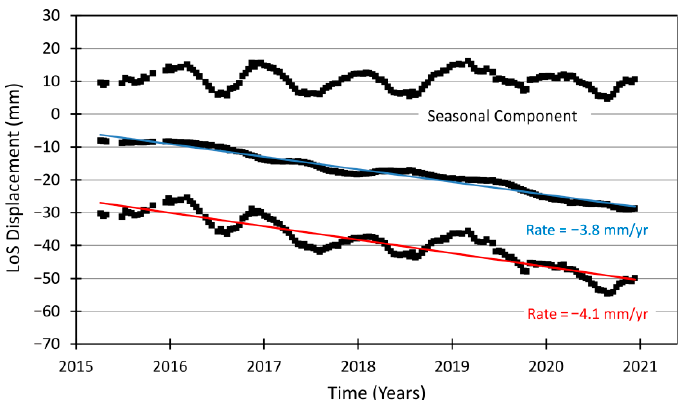
Figure 10. PSI displacement time series for ascending track 102 at the location of high subsidence rates within the basin. The calculated trend (low pass filtering) has been subtracted from observed LoS displacements to obtain the seasonal component. The annual seasonality and linear trend are consistent to water table variations in underground aquifers. Time series has been arbitrarily shifted for visualization purposes.